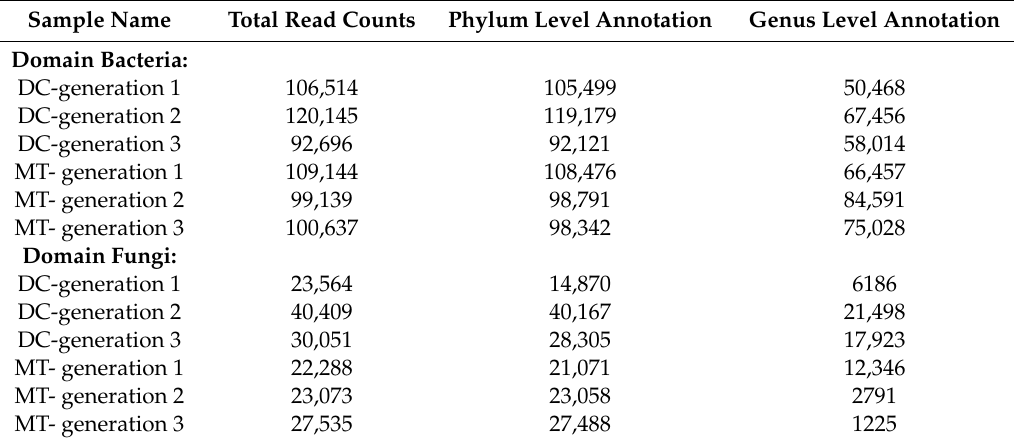
Table 1. Taxonomic assignment of metagenomic sequences obtained from di ff erent generations of the di ff usion chamber (DC) and microbial trap (MT) established with uranium contaminated